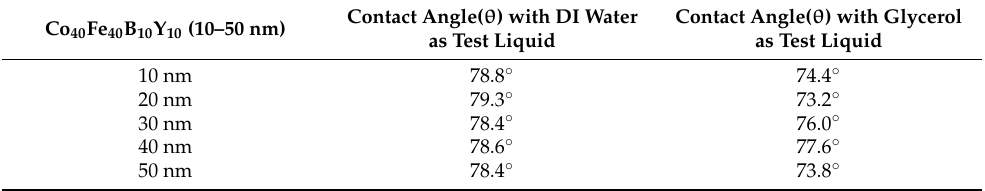
Table 5. Average contact angles of CoFeBY thin films after annealing at 200 ◦ C with DI water and glycerol.